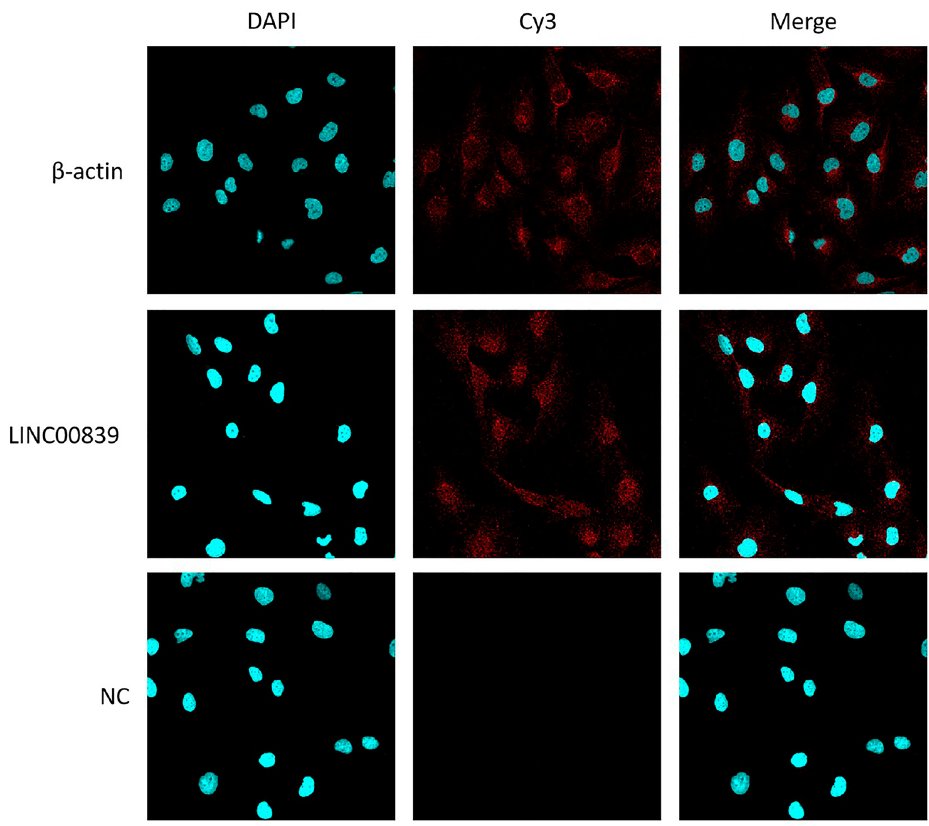
Figure 4. LINC00839 is located in both the nucleus and cytoplasm of liver cancer cells. The unrelated sequence to human gene was used as